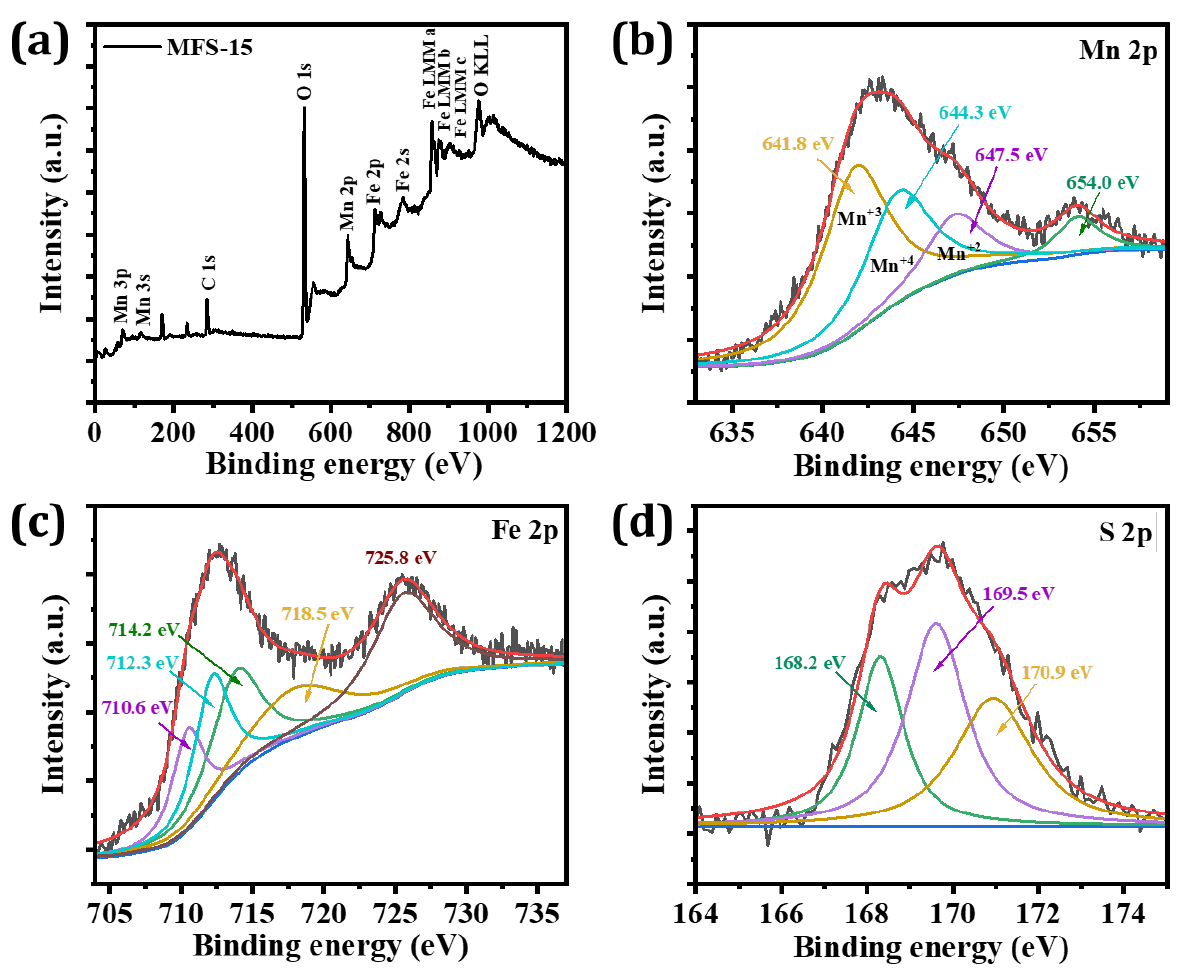
Figure 1. X-ray photoelectron spectroscopy of MFS-15 sample, ( a ) survey scan, ( b ) core-level spectra of Mn 2p, ( c ) core-level spectra of Fe 2p, and ( d ) core-level spectra of S 2p.